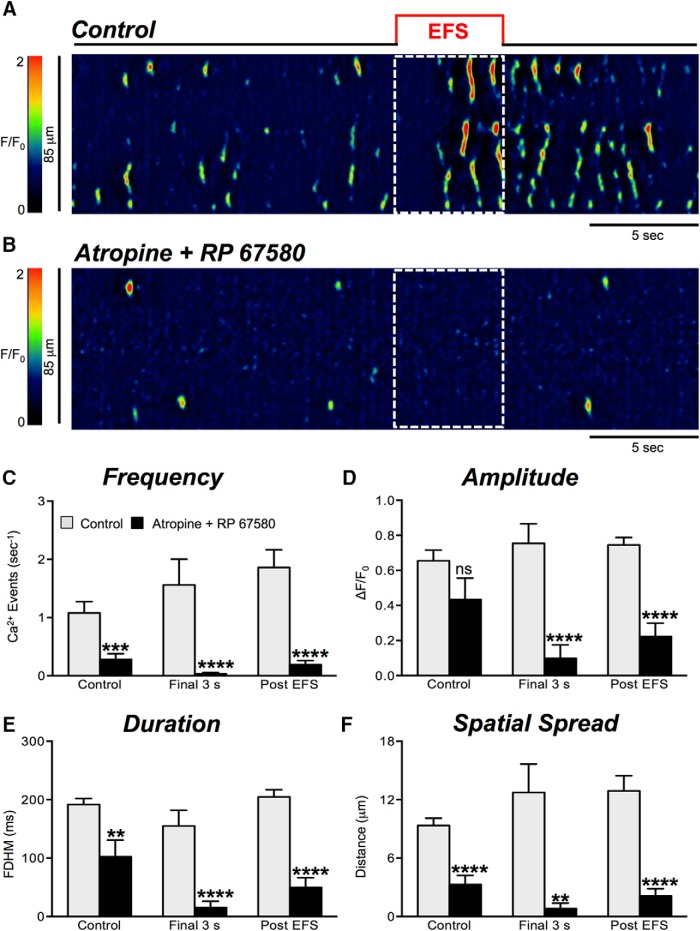
Cholinergic and NK1 receptor antagonists inhibit Ca2+ transients elicited by EFS in ICC-DMP. A, B, Representative ST maps showing the inhibitory effects of combining cholinergic and neurokinin antagonists (atropine and RP 67580; both 1 μM) on Ca2+ transients in ICC-DMP during EFS (10 Hz; 5 s). C–F, Summary data of Ca2+ transient parameters showing the inhibitory effects of atropine and RP 67580 on Ca2+ transient frequency (C), amplitude (D), duration (E), and spatial spread (F) in ICC-DMP during the control period, during the final 3 s of EFS, and during the post-EFS period (5 s), n = 4, c = 20. Note: combination of atropine and RP 67580 abolished all Ca2+ transient parameters significantly; ns = p > 0.05, **p < 0.01, ***p < 0.001, ****p < 0.0001.